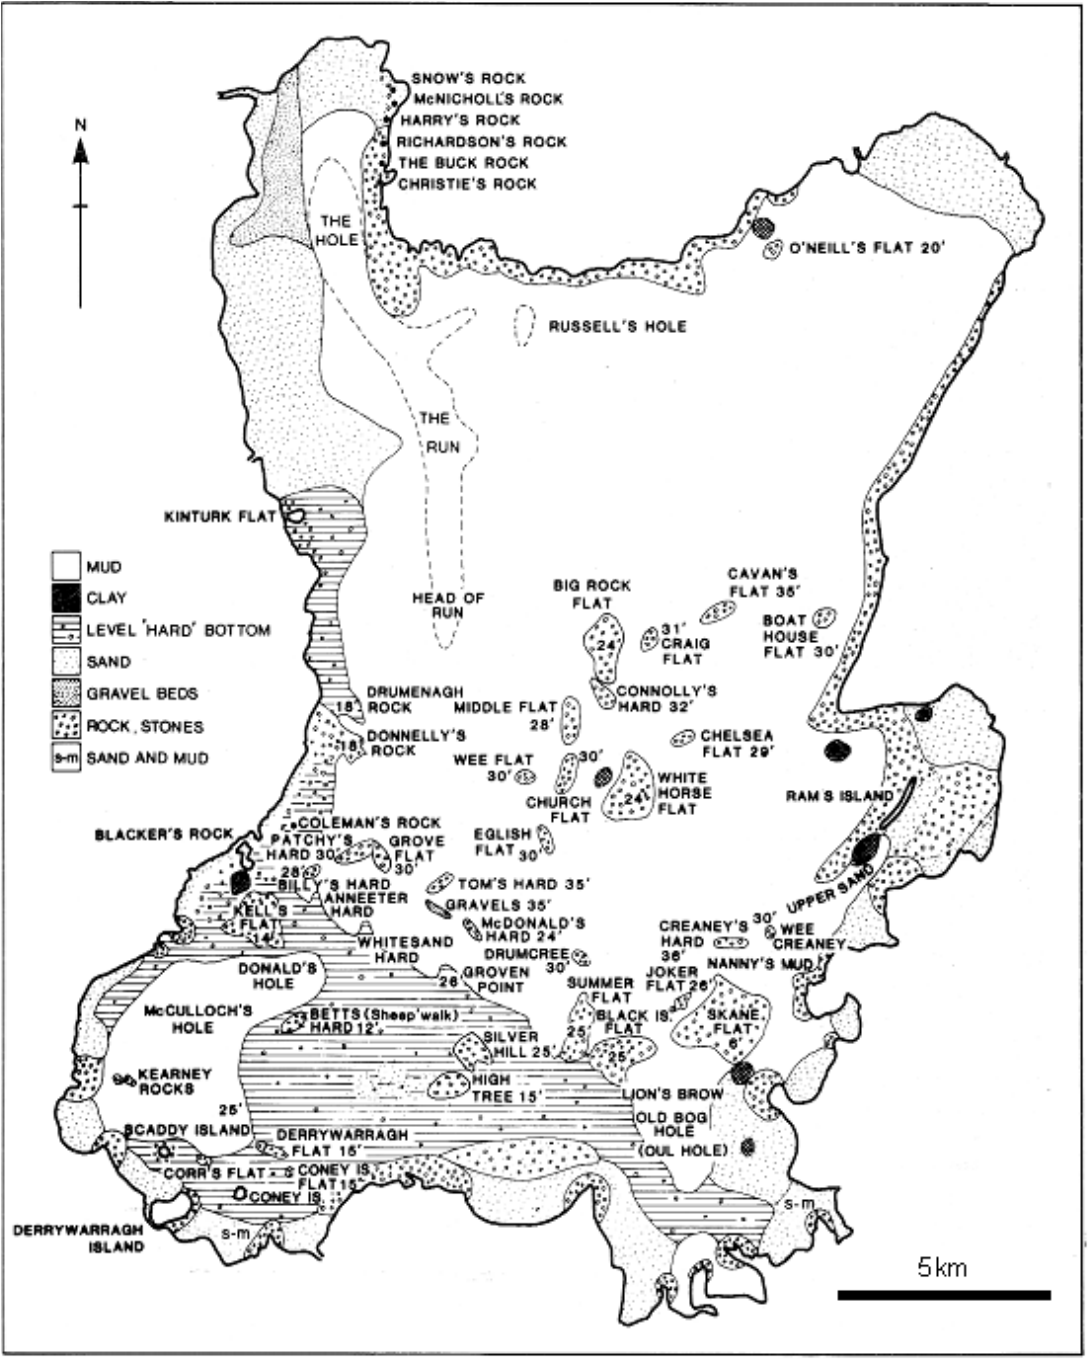
Fig. 2. Mental map of the substrate of Lough Neagh as perceived by local fishermen (after Donnelly